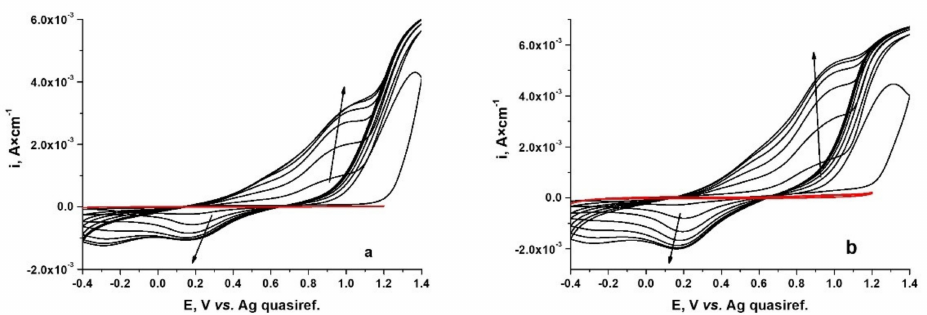
Figure 1. Cyclic voltammograms on WBC ( a ) and Hera ( b ) CoCr alloys during electrosynthesis of PPy from ionic liquids electrolyte containing 0.5 M Py. The scan rate was 10 mV s − 1 . (Red line: CVs for CoCr alloys in electrolyte without